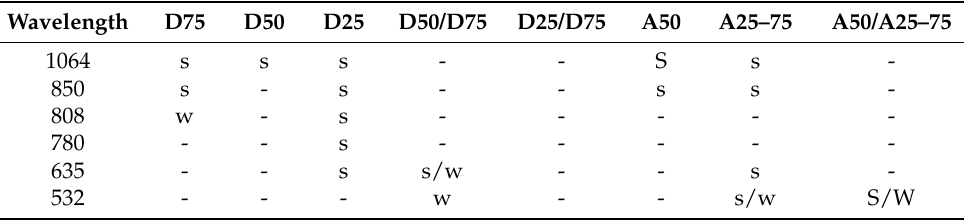
Table 4. Sensitivity of backscattering signal parameters according to the ANOVA test.